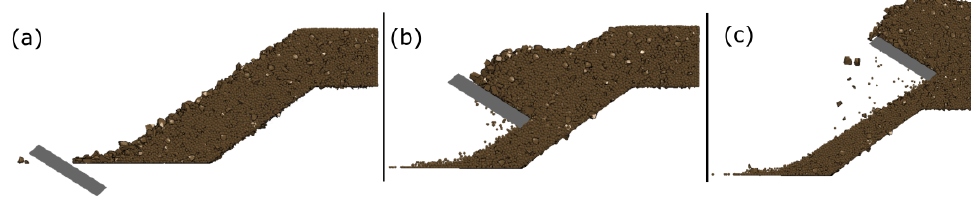
Figure 9. Snapshots showing the creation of one muck-pile. A plate is moved across the muck pile ( a – c ). After the bucket has reached the top of the pile, the contact between the granular material and the plate is removed and the material flows due to gravity. The final pile is the one shown in Figure 8c.